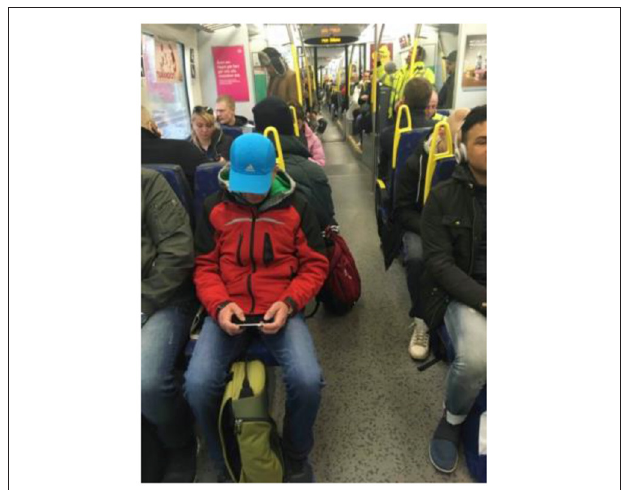
FIGURE 2 | Train at 6.07